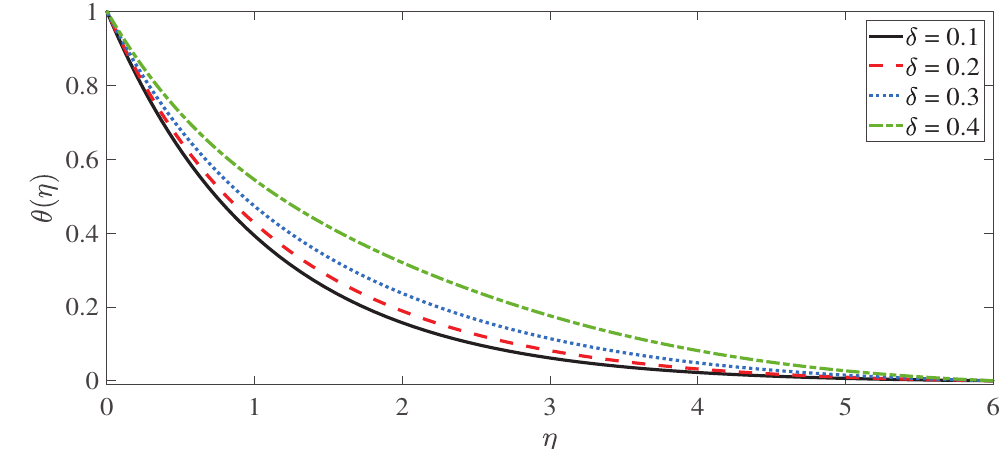
Figure 7. Temperature profile for local heat generation parameter δ